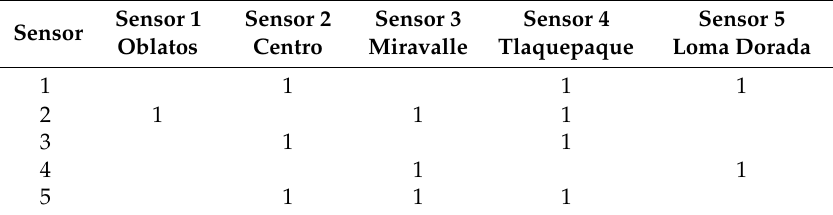
Table 4. Neighboring sensors